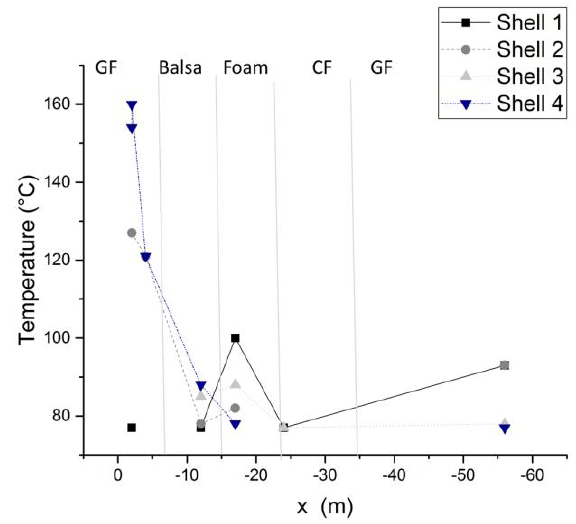
Figure 3. Maximum tooling surface process temperatures